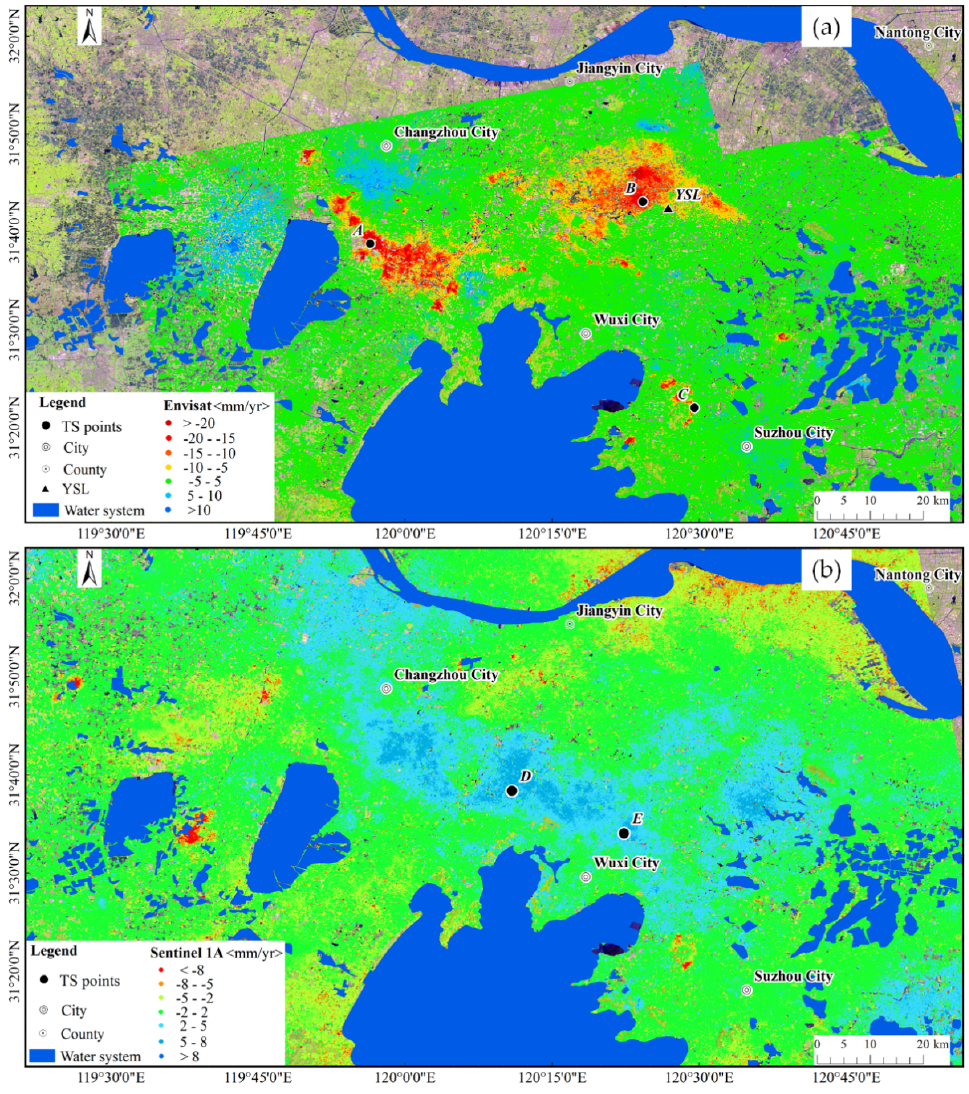
Figure 5. Su-Xi-Chang area deformation rates derived from SAR data. InSAR results inferred from ( a ) E nvisat T39 and Envisat T268, and ( b ) Sentinel 1A. Three time-series (TS) points were selected from the subsidence regions (Wuxi, Suzhou, and Changzhou) to obtain the time-series deformation, as shown in Figures 5a and 6a. From November 2007 to May 2010, point A, which is located in the settlement center of Changzhou, had a cumulative settlement of 68 mm; point B was located in the settle- ment center of Wuxi, south of JY, with a cumulative settlement of 67 mm; and point C was